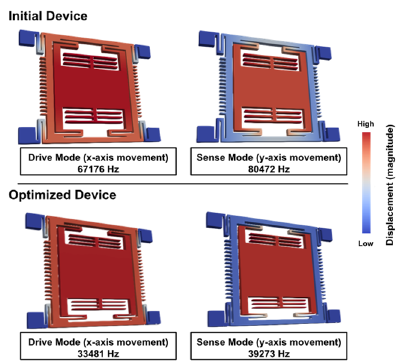
Figure 12. Mode shapes of initial and optimized MEMS